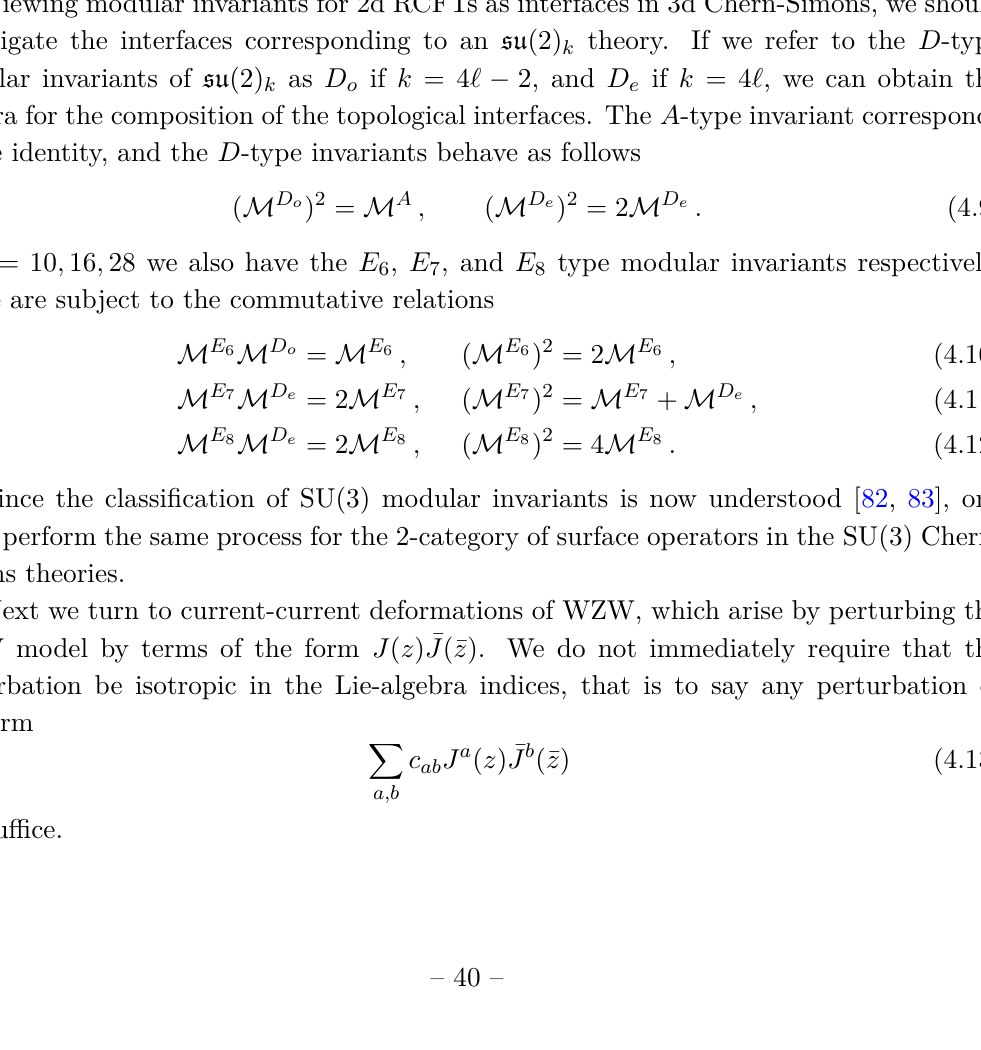
are in bijection with operators i,j